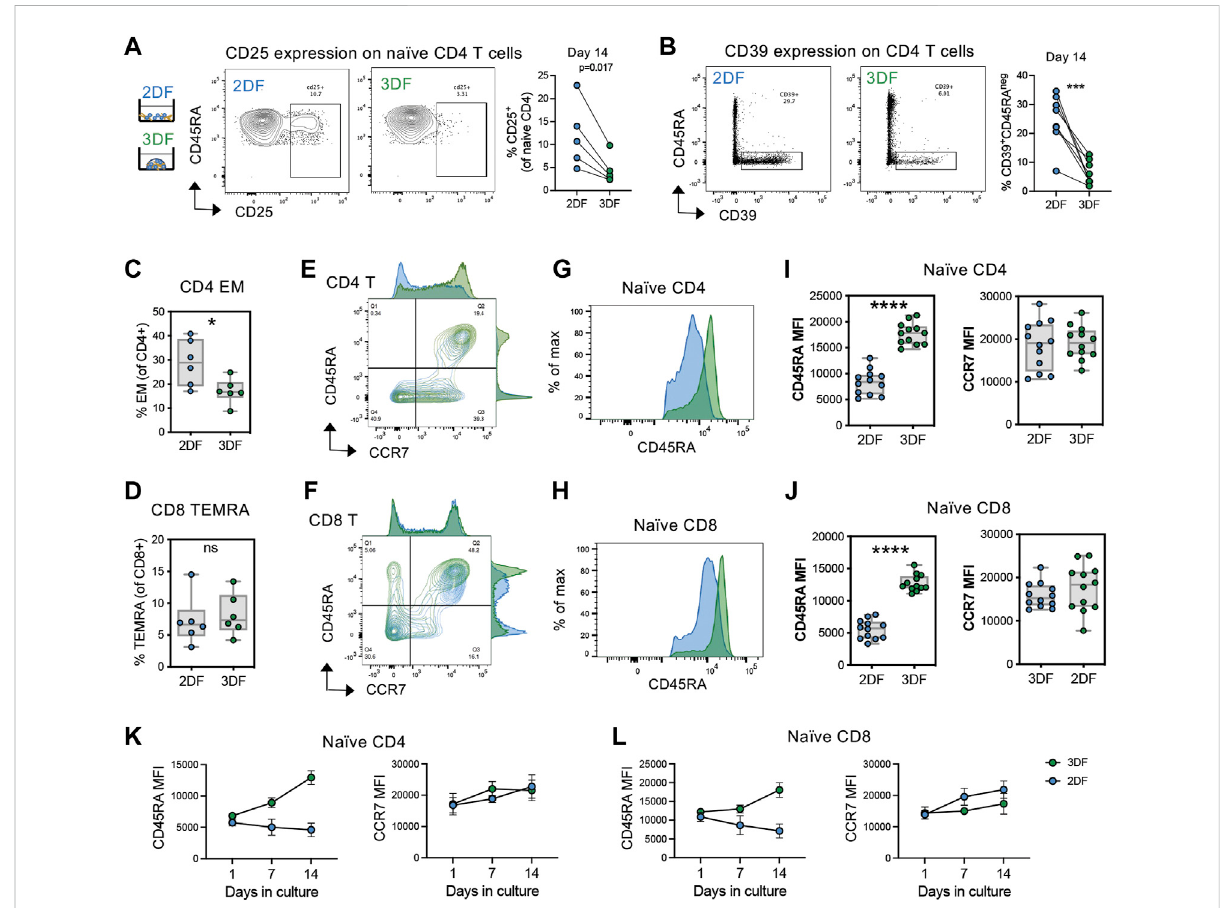
FIGURE 2 SLT-organoids prevent T cells from acquiring features of immune aging and naïve cell-speci fi c decline in CD45RA expression. (A) CD25 + naïve CD4 T cell frequencies in naïve CD4 T cells in 2DF and 3DF ( n = 5 young adult T cell donors) after 14 days of culturing. (B) CD39 + CD45RA neg CD4 T cells frequencies in total CD4 T cells in 2DF and 3DF ( n = 8 young adult T cell donors) after 14 days of culturing. (C) Effector memory (CD45RA neg CCR7 neg )CD4Tcelland (D) TEMRA(CD45RA + CCR7 neg )CD8Tcellfrequenciesin2DFand3DF( n =6youngadultTcelldonors)after 14 daysofculturing. (E,F) Distributionof (E) CD4and (F) CD8TcellsbyCD45RAandCCR7expressionafter14 daysofculturing. (G,H) Representative histograms of CD45RA expression on naïve (CD45RA + CCR7+) (G) CD4 and (H) CD8 T cells in 2DF and 3DF after 14 days of culturing. (I,J) CD45RA and CCR7 MFIon naïve (I) CD4 and (J) CD8 Tcells in2DF and3DF( n =6 young adultTcell donorsdone induplicate) after 14 days of culturing. (K, L) CD45RA and CCR7 MFI over time on naïve (K) CD4 and (L) CD8 T cells in 2DF and 3DF (n = 6 young adult T cell donors done in duplicate). * p <